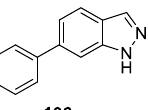
Figure 19. Chemical structure of 1 H -indazole derivative 107. A series of 1 H -indazole derivatives were synthesized using structure-guided drug design from lead compound 108 by Liu et al. [64] and evaluated for their epidermal growth factor receptor (EGFR) kinase activity. The results indicated that compound 109 displayed strong potencies against EGFR T790M and EGFR kinases with IC 50 values of 5.3 and 8.3 nM, respectively (Figure 20). In particular, compound 109 displayed strong antiproliferative effects against EGFR mutant-driven non-small cell lung cancer (NSCLC) cell lines such as H1975, PC9, HCC827, and H3255 without obvious toxicity. Figure 20. Chemical structures of 1 H -indazole derivatives 108 and 109. Hah et al. [65] reported the synthesis of novel 3-carboxamido-2 H -indazole-6-arylamide derivatives as selective CRAF inhibitors. The compounds were evaluated for antiproliferative activity against the WM3629 melanoma cell line. Results revealed that most of the compounds displayed potent antiproliferative activity against the WM3629 melanoma cell line. In particular, compounds 110 and 111 exhibited superior selectivity (Figure 21). Compound 110 was found to be the most promising inhibitor against the WM3629 melanoma cell line with IC 50 value of 38.6 nM, which also